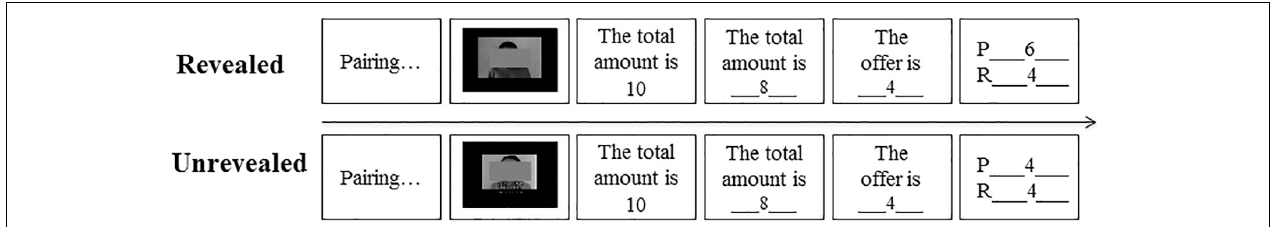
FIGURE 1 | The procedure of Experiment 1. Two sample trials was shown, in which both gains of P (proposer) and R (recipient) based on P’s true total would be revealed (R) or only the gains based on P’s reported total would be revealed and their true totals would not be revealed (UR).